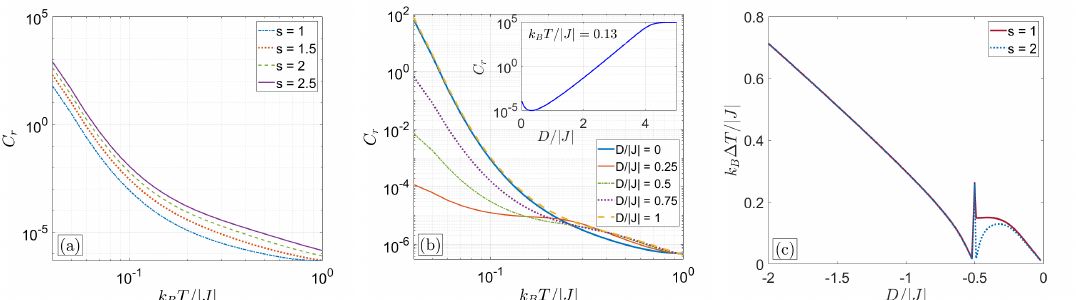
Figure 6. ( a , b ) Temperature dependencies of the cooling rates C r on approach to h f = 0 in the adiabatic process with the zero-field GS degeneracy in the T cluster for ( a ) D / | J | = 0 and different spin values and ( b ) for s = 1 and different single-ion anisotropy. The inset in panel ( b ) shows the single-ion anisotropy dependence of C r for k B T / | J | = 0.13. ( c ) Single-ion anisotropy dependence of the temperature change when decreasing the field from h i = h c 1 to h f = 0 in the adiabatic process with the entropy corresponding to the ground-state degeneracy at h c 1 / | J |